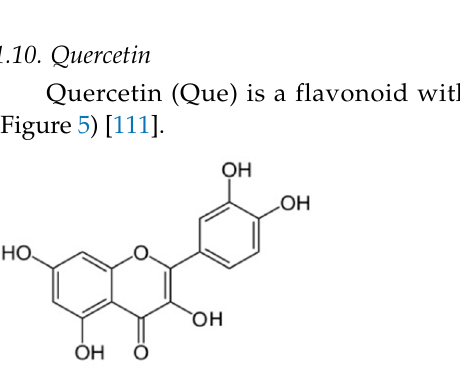
Figure 5. Quercetin Structure (3,30,40,5,7-pentahydroxyflavone).